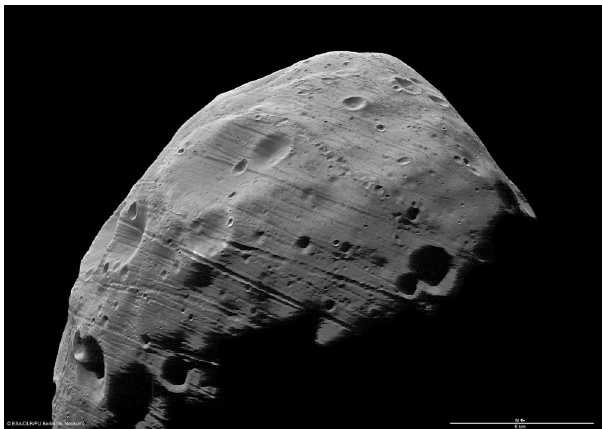
Fig. 1 The Martian satellite Phobos was the fi rst small body imaged in detail. It orbits so close to Mars that without friction or strength it would fall apart due to tides. It is spiraling in and expected to come apart in tens of millions of years, forming a debris ring and causing an intense planetary equatorial bombardment. Shown is one of the highest resolution images yet obtained (scale bar 5 km; 3.7 m/pixel), acquired by Mars Express whose polar orbit sometimes crosses that of Phobos. The network of parallel grooves correlate with the direction of growing tidal strain, and may be a precursor to global failure and a hint at what ’ s inside (ESA/DLR/FU Berlin).